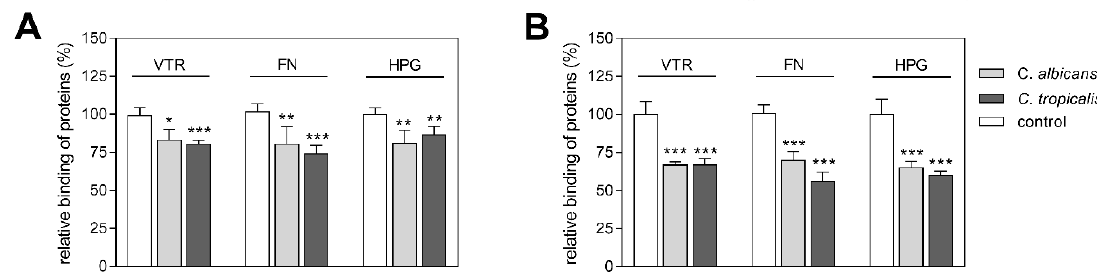
Figure 1. Effects of C. albicans and C. tropicalis purified enolases ( A ) or anti-enolase antibody ( B ) on the binding of biotin-labeled human proteins ― vitronectin (VTR-Bt), fibronectin (FN-Bt), plasminogen (HPG-Bt) ― to Candida spp. cells. Candida spp. hyphal or pseudohyphal forms, settled in the wells of a MaxiSorp microplate (1 × 10 6 cells per well), were ( A ) incubated with mixtures of 40 µL of VTR-Bt, FN-Bt or HPG-Bt (at the final amount of 2 pmoles) with 10 µL of purified Candida spp. enolases (final amount of 24 pmoles); or ( B ) pre-incubated with the fungal anti-enolase antibodies (1 µg/µL and then treated with 50 µL of VTR-Bt, FN-Bt or HPG-Bt (at a final concentration of 250 nM). After washing off unbound protein, the amount of bound human protein was determined using the streptavidin-horseradish peroxidase/tetramethylbenzidine SA-HRP/TMB system. Bars represent the mean values from three determinations with standard deviations. Statistical significance levels against the 100% controls were determined using a one-way ANOVA test: * p < 0.05, ** p < 0.01 and *** p < 0.001.